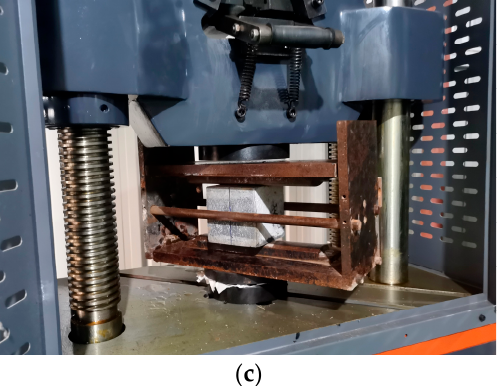
Figure 5. Test device for mechanical properties: ( a ) compressive strength test, ( b ) flexural strength test, and ( c ) spli tt ing tensile strength test.